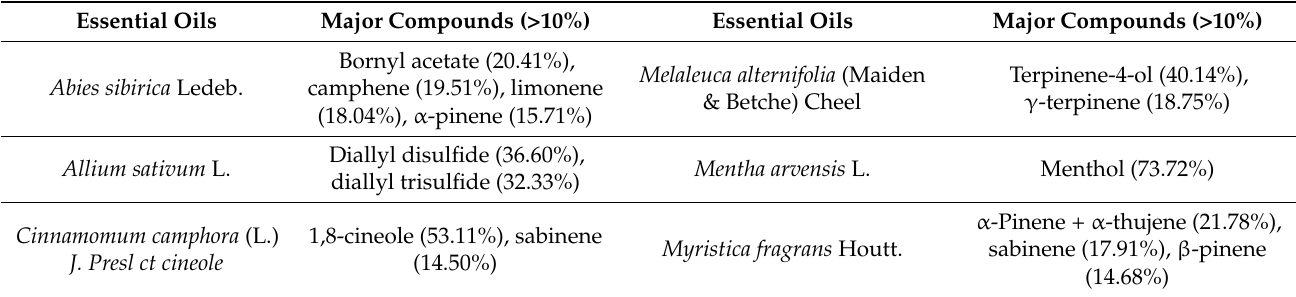
Table 1. List of the essential oils tested and their composition for compounds (main compounds representing more than 10% of the total composition on peak area